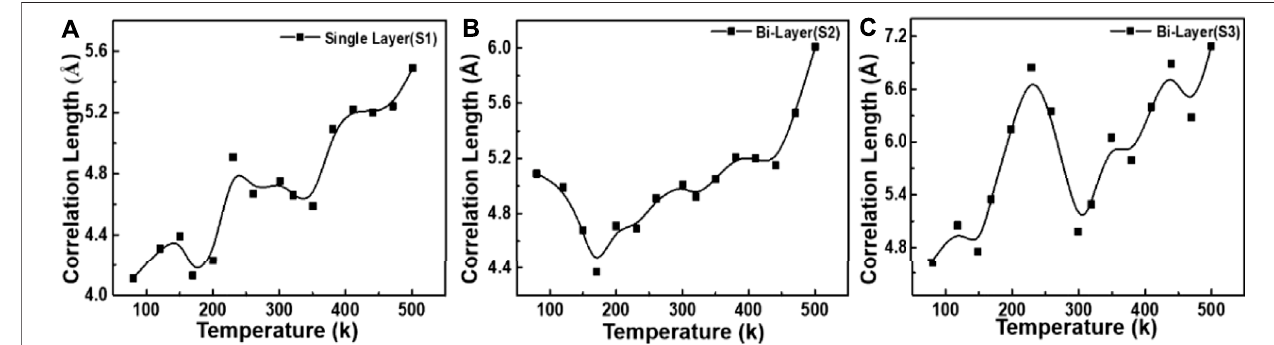
1 cm × 1 cm). Figure 7C is the charge transfer ( Q sc ) of three TENGs at room temperature. D-TENG had the highest Q sc of about 0.71 nC and C-TENG had the lowest Q sc of about 0.30 nC. The results of a short-circuit current ( I sc ) and an open-circuit voltage ( V oc ) for the